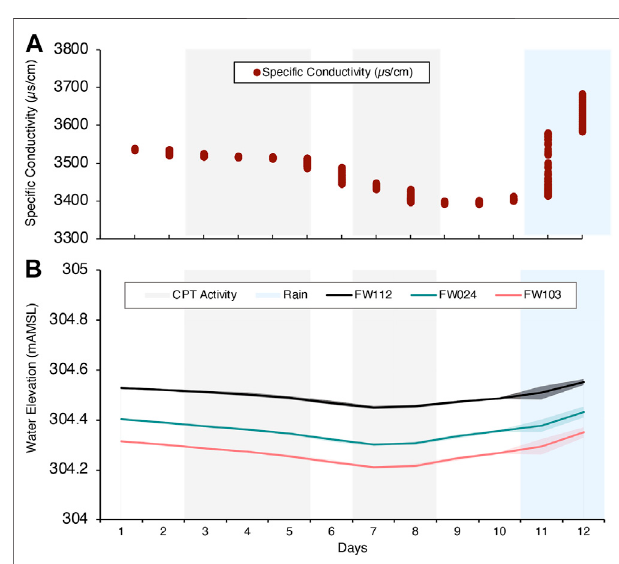
FIGURE 6 | Groundwater responseto rainfalland CPT activity. (A) is the continuous monitoring of speci fi c conductivity in FW106 which shows no change in response based on CPT activity. Rainfall on days and 11 and 12 causes a spike in conductivity that causes ∼ 300 µs/cm increases the speci fi c conductivity over 48 h. (B) demonstrates a similar trend observed for water level. The solid line in panel B is the mean daily water elevation and the shaded range is the daily standard deviation. Water level variation remains consistently low throughout CPT activity until the rainfall events on days 11 and